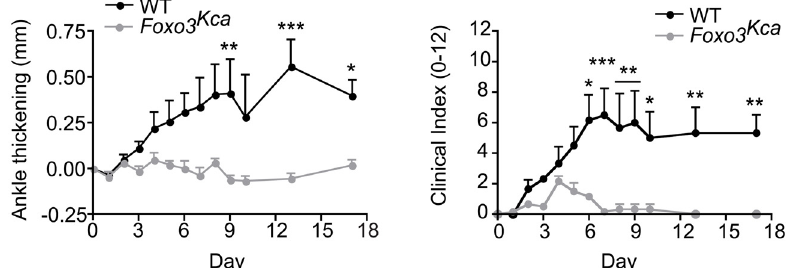
Fig 4. Foxo3 Kca mice exhibit reduced severity of arthritis. WT and Foxo3 Kca mice were injected i.p. with K/ BxN sera on d 0 and d 2 and ankle thickness and clinical scores were determined in blinded fashion. Graphs show the ankle thickening of WT or Foxo3 Kca mice (Left) or clinical index of paws (Right). Data are representative of at least three independent experiments with at least six paws (for ankle thickening) or 3 mice (for clinical index) per